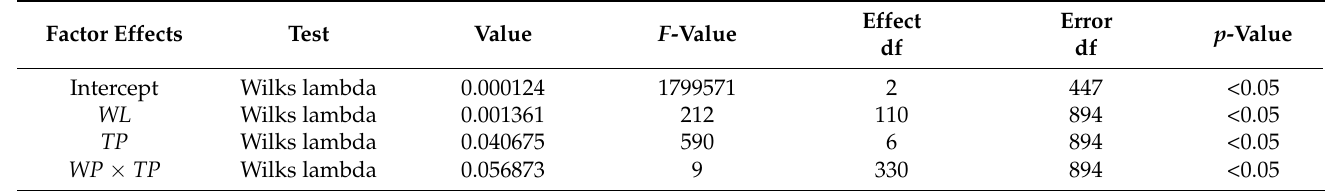
Table 10. Multivariate tests of significance of the factors’ effects on absorbance and transmittance.